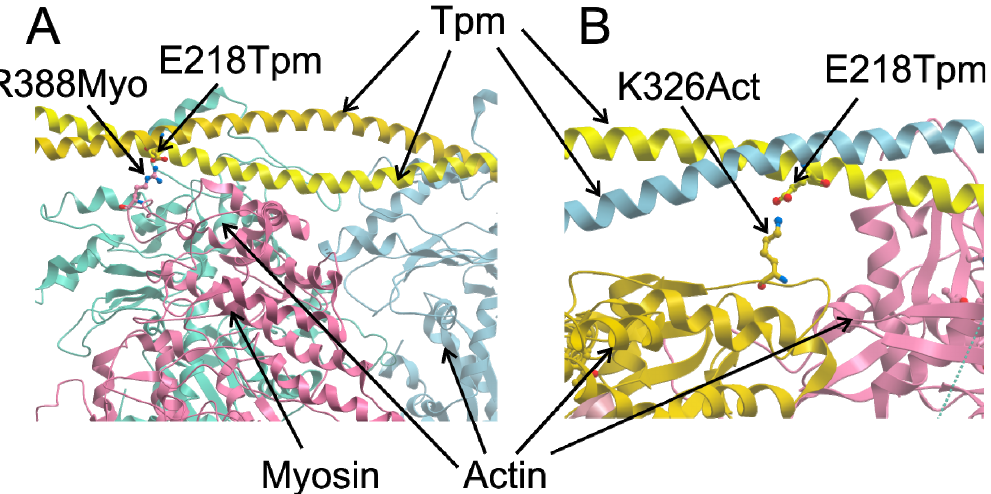
Figure 8. Structural models illustrating possible involvement of the Glu218 Tpm residue in the interaction with myosin ( A ) and actin ( B ). The models were obtained by minor side-chain modifications using a rotamer library with UCSF Chimera [37] from the structure of the F-actin–Tp–myosin complex in the open state ( A , [35], PDB entry 4A7H) and the F-actin-Tpm complex in the closed state ( B , [36], 6KN8).